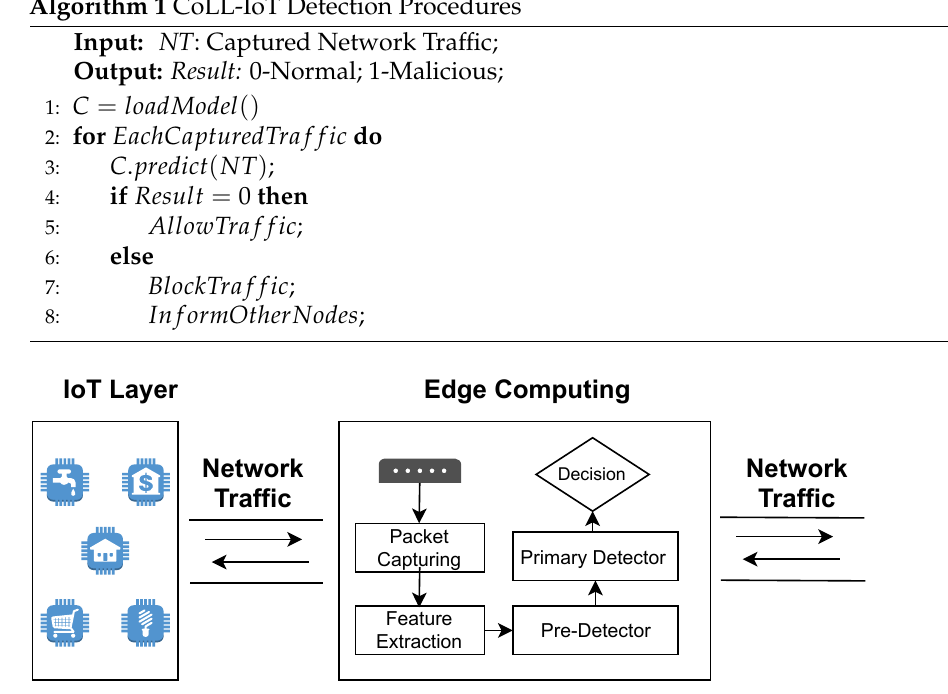
Figure 6. Architecture of Edge Computing Device in the Proposed